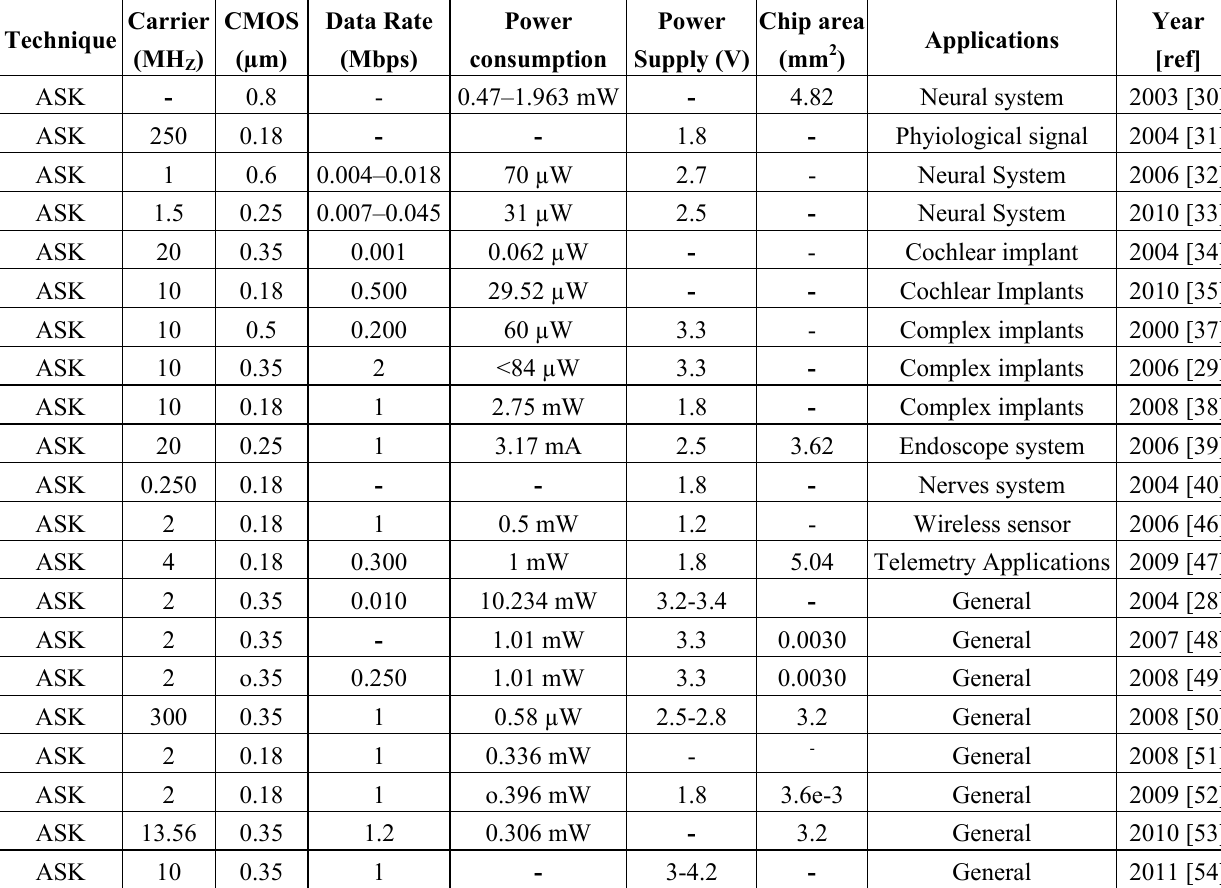
Table A1. ASK modulations used in telemetric wireless and implanted